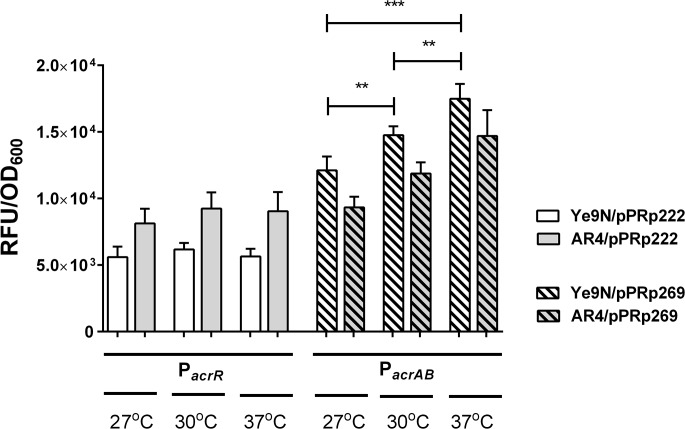
The influence of growth temperature on acrR and acrAB promoter activity.Strains Ye9 and AR4 carrying the promoter-gfp fusion constructs were cultivated in LB medium at 27°C, 30°C or 37°C to exponential phase. Data represent mean fluorescence activity values normalized to the OD600 of the culture (± standard deviation) from three independent experiments performed in triplicate. Significance of differences between the values was calculated using Student’s unpaired t-test (**—p<0.01, ***—p<0.001).